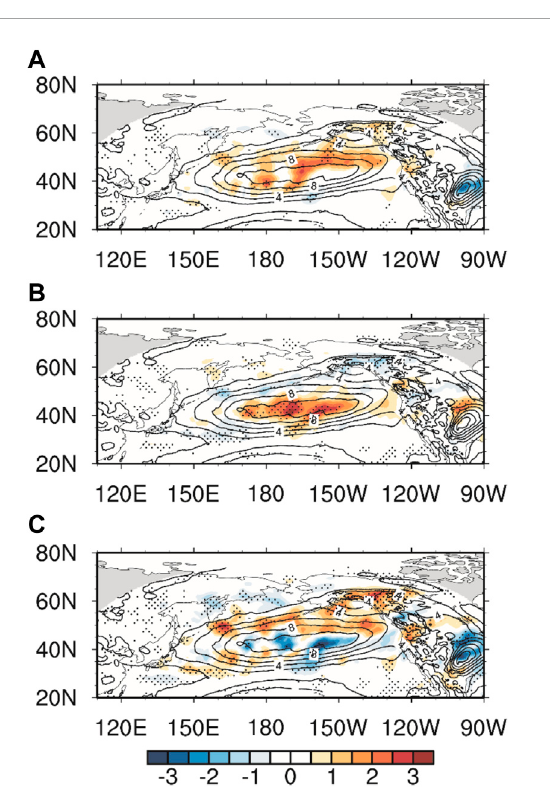
Response of storm tracks (m 2 s − 2 , shading) at 250 hPa to different scales of KE-related SSTAs in KE in the cold season: (A) KE-related mesoscale SSTAs (KSTS-MEFS) and (B) KE-related large-scale SSTA background (MEFS-CTRL). (C) Differences intheresponseofstormtrackstoKE-relatedmesoscaleSSTAsand the response of storm tracks to KE-related large-scale SSTAs. The isoline is the climatological storm track simulated by the model (CTRL). Statistically signi fi cant differences at 90% according to Student ’ s t test are stippled.